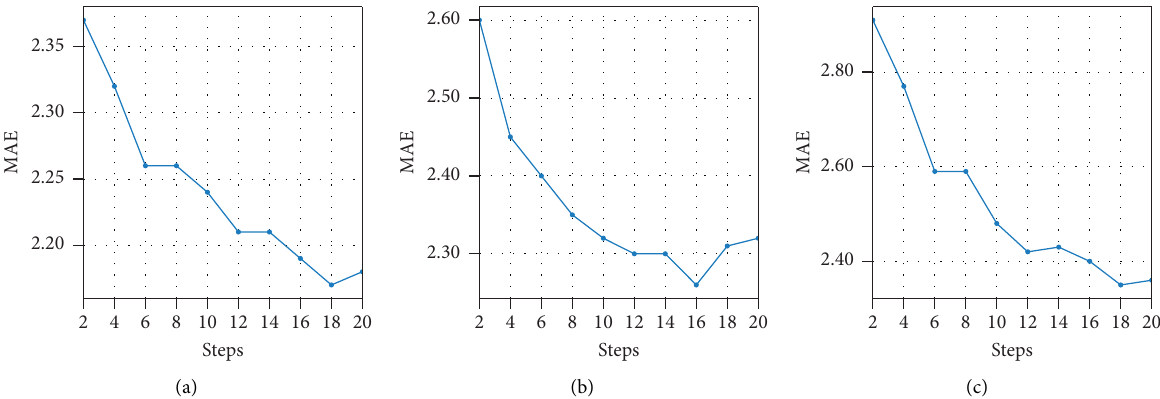
Figure 5: MAEs of the GRU model with different backtracking steps on detector 16,885. (a) 20-minute interval. (b) 30-minute interval. (c) 60-minute